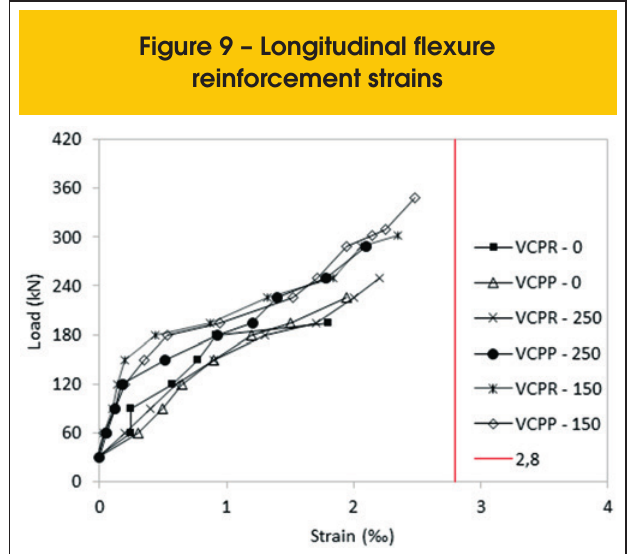
Figure 9 – Longitudinal flexure reinforcement